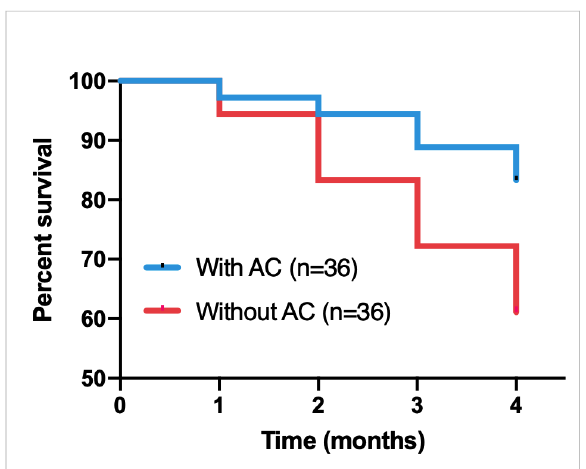
FIGURE 2 Survival curves of P. notoginseng either with or without AC addition in hydroponics. Through Kaplan-Merier with log-rank test